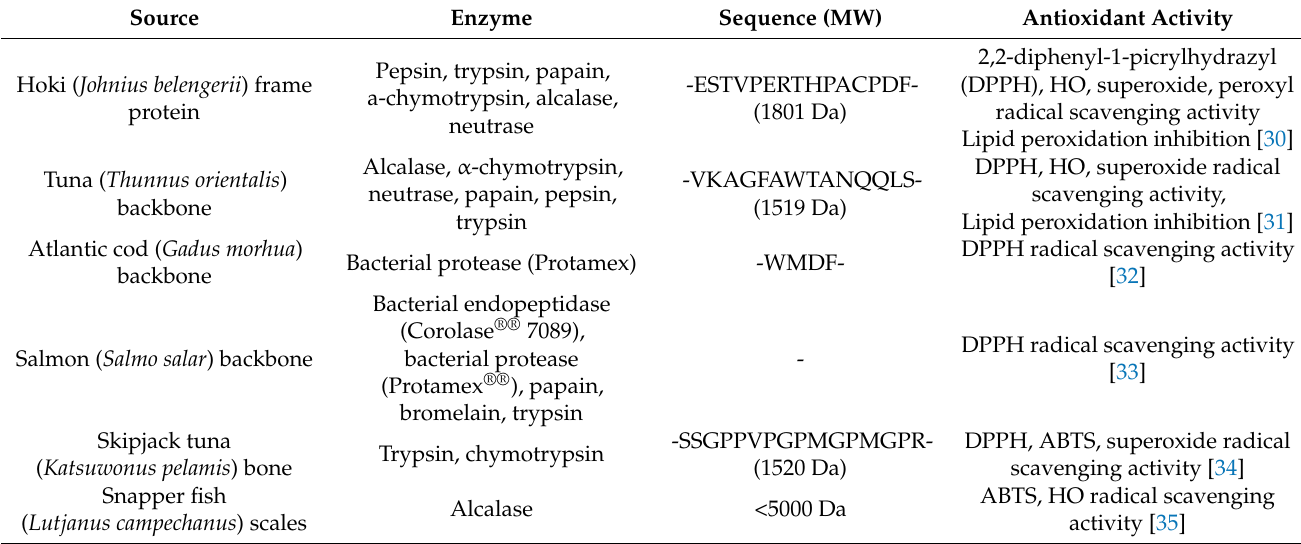
Table 1. Antioxidant activity of fish bone